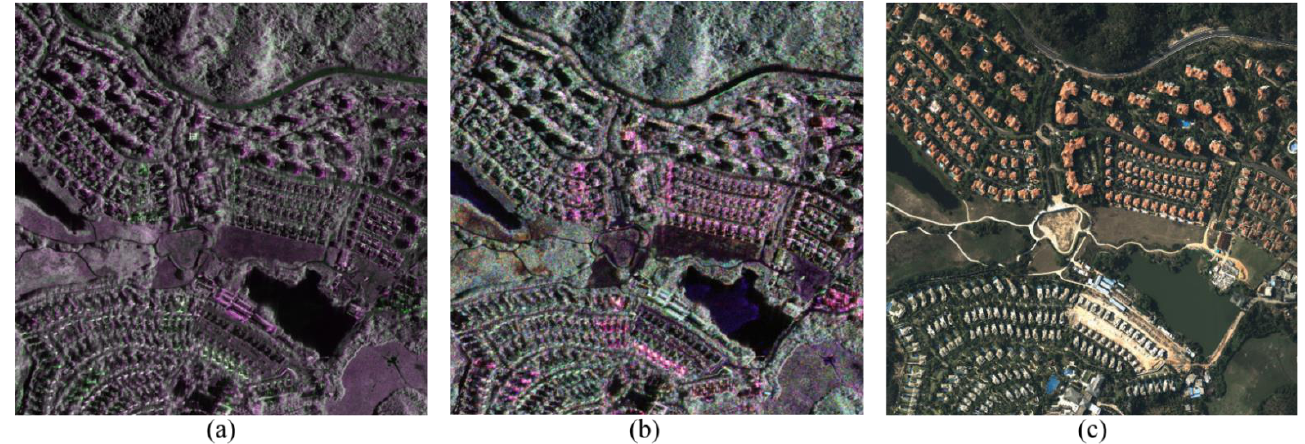
Figure 4. Scene 2. ( a ) Ka-band multi-polarization SAR image. ( b ) S-band multi-polarization SAR image. ( c ) Optical image.